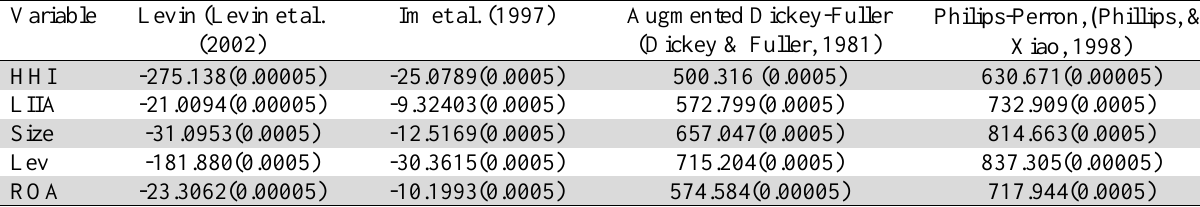
The summary of unit root test using different techniques